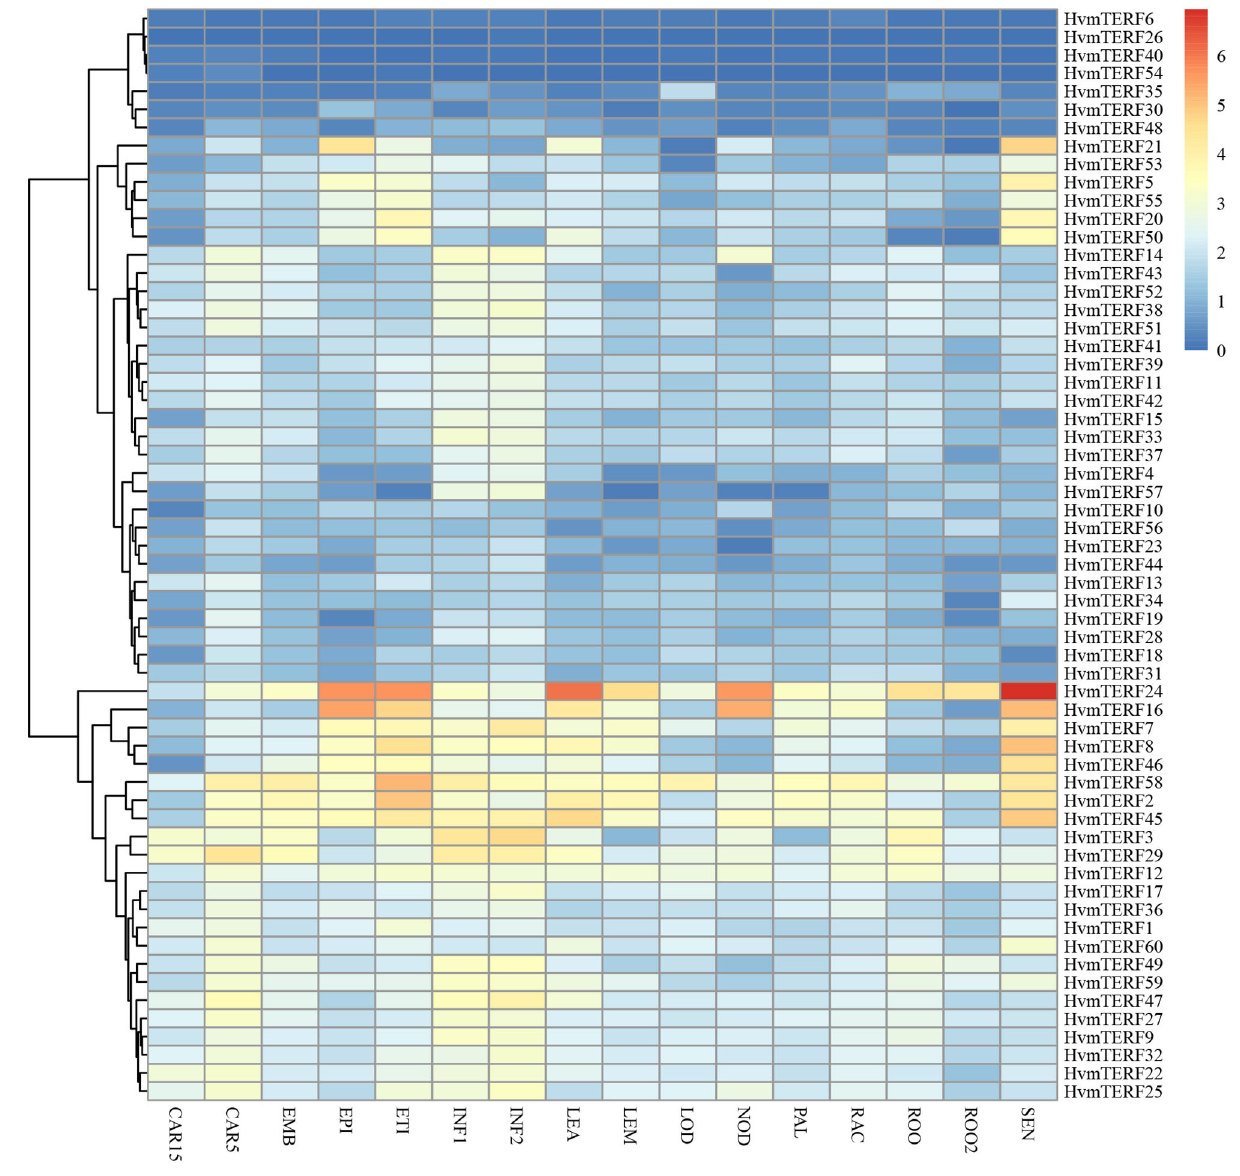
were downregulated. Furthermore, HvmTERF50 was upregulated in the meristematic zone and downregulated in the mature zone. HvmTERF10 was upregulated in the elongation zone and downregulated in the mature zone. Notably, HvmTERF21 was upregulated in both the meristematic zone (3.49-fold) and elongation zone (4.01-fold) and downregulated in the maturation zone